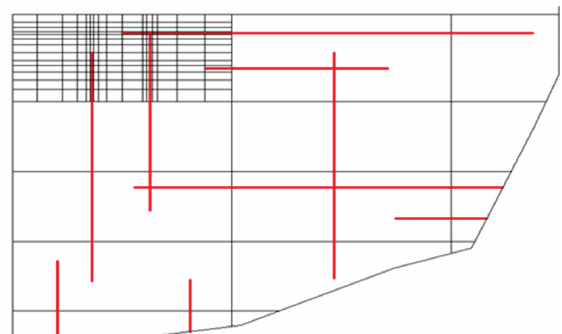
Figure 2: The fine and the coarse mesh used with the fractures.